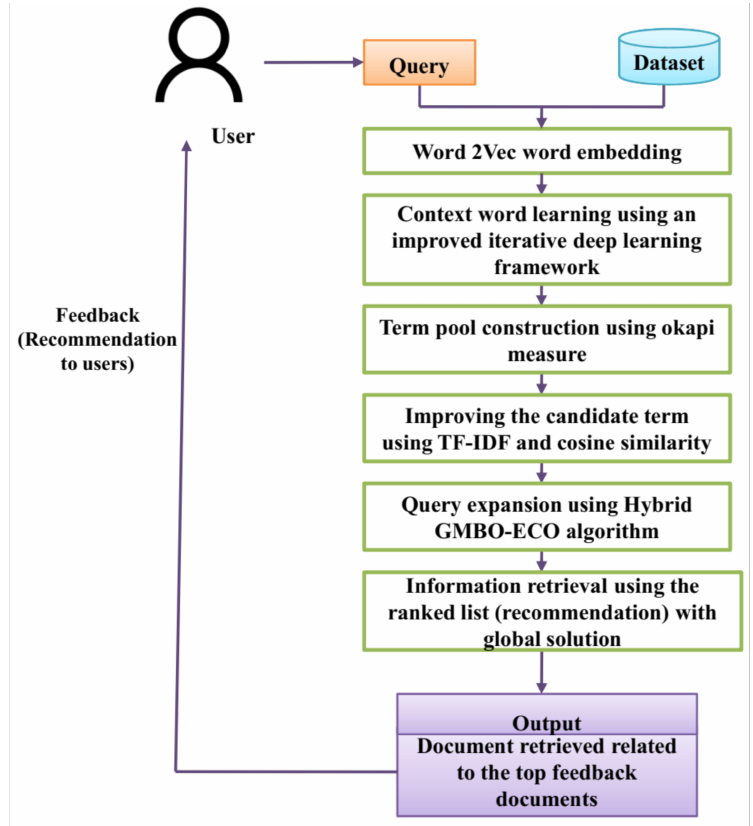
Figure 1. Outline of the proposed